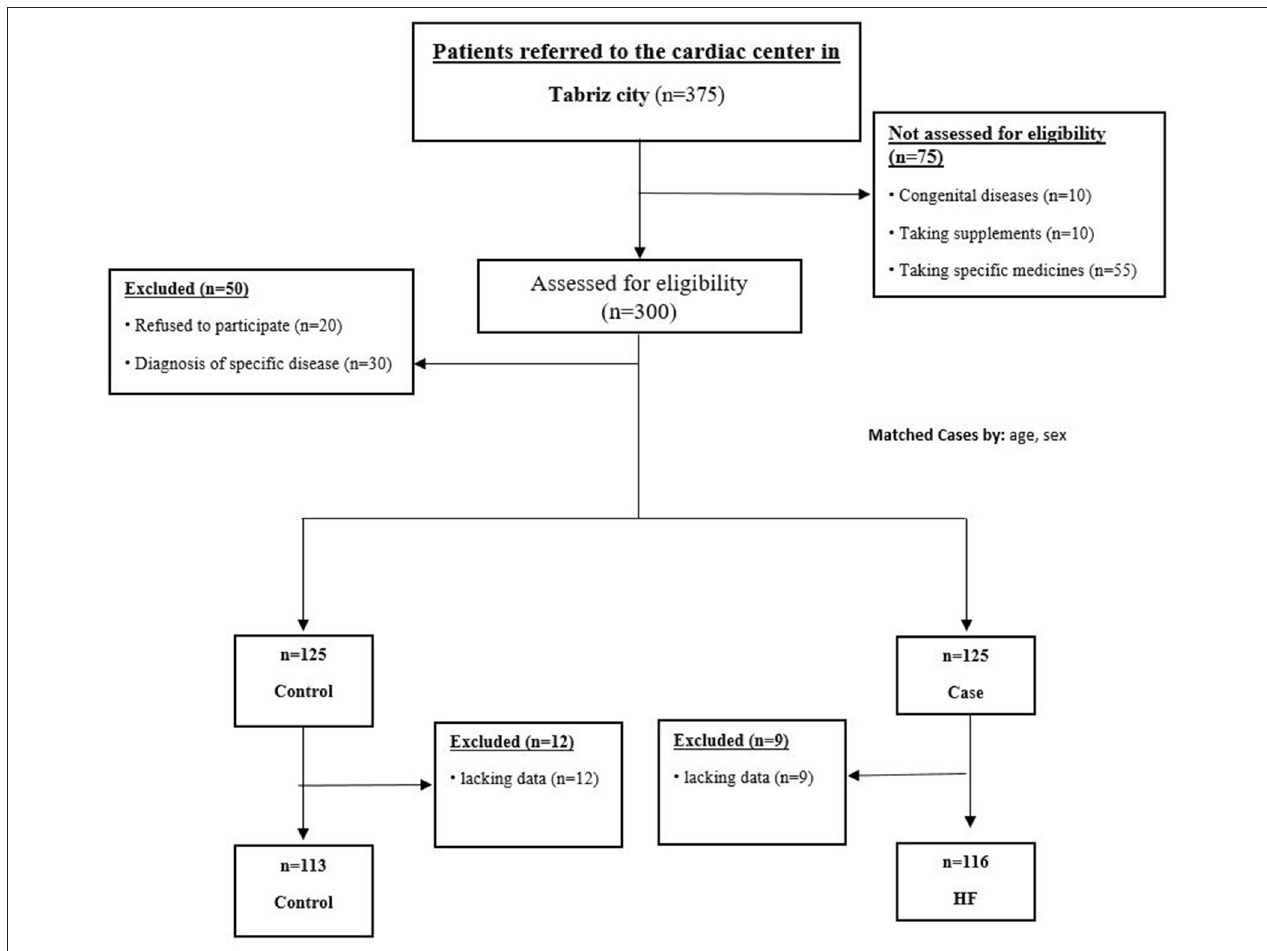
FIGURE 1 | Flowchart of